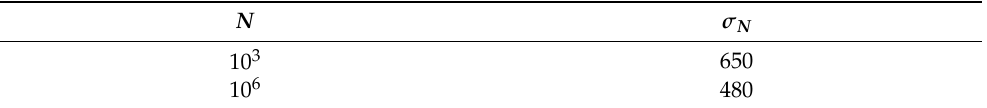
Table 12. Cycle times and relative stress.